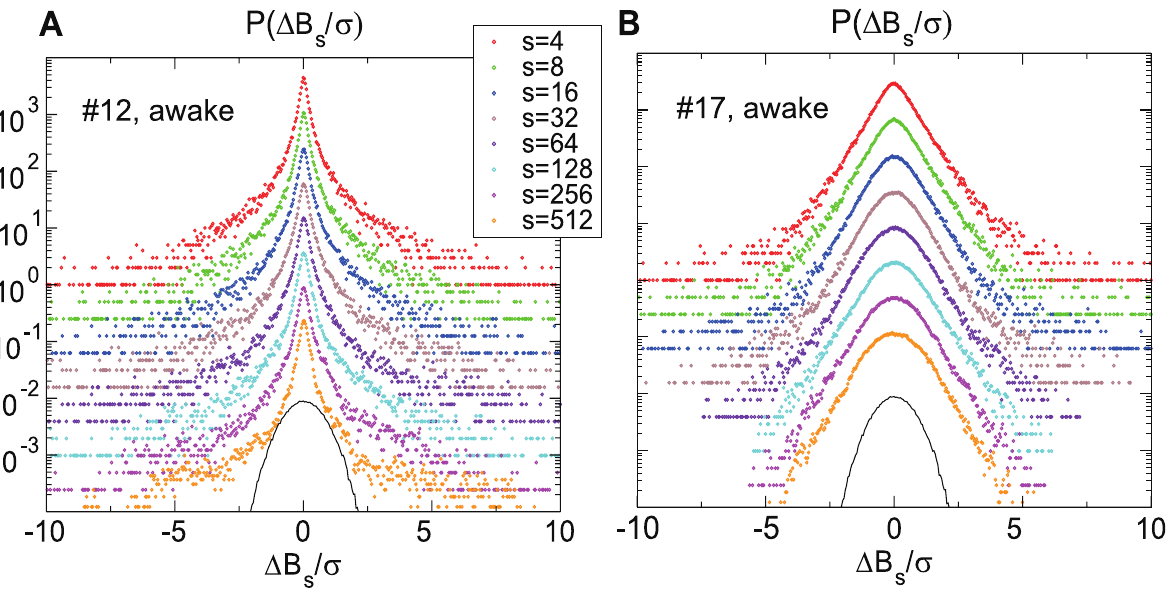
Figure 2. The probability distribution function (PDF) of the normalized ISI fluctuations. PDFs calculated at eight different coarse graining scales are displayed for neurons indexed as # 12 (A) and # 17 (B). Both spike trains were taken from waking periods. The parabola representing the perfect Gaussian distribution is placed at the bottom of each panel to help readers see the degree of non-Gaussianity. The spike train from # 12 is highly non-Gaussian, while that from # 17 is weakly non-Gaussian.